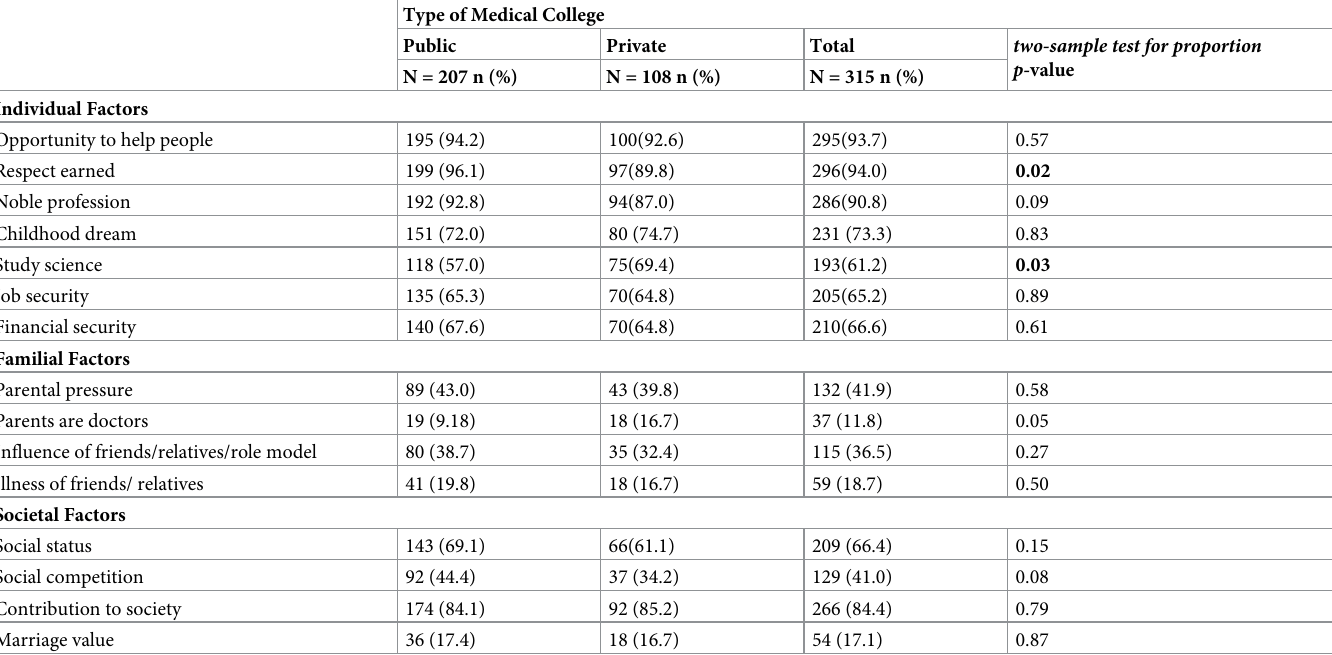
Table 4. Female medical students’ reported reasons for choosing medicine as a field of study (N = 315).